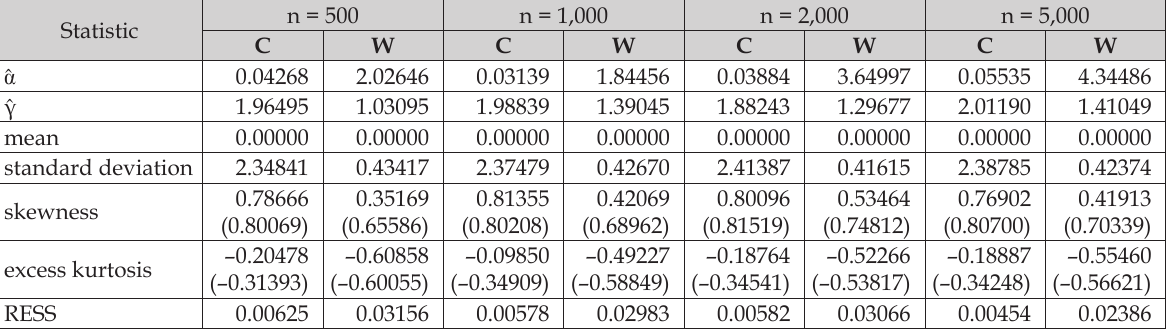
Table C1. Summary statistics for selected Thiessen polygon surface partitionings based on random